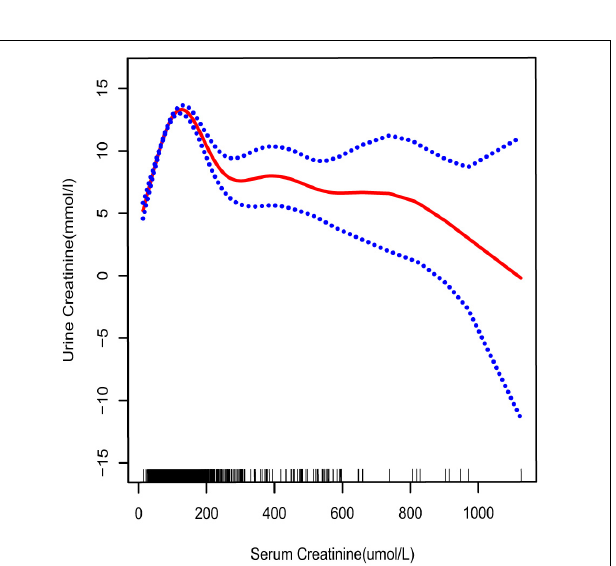
and Figure 5 ), women (inflection point: UCR 2.829 mmol/L) ( Table 4 and Figure 2 ), and other race (inflection point: UCR 8.221 mmol/L) ( Table 4 and Figure 3 ). This study demonstrated